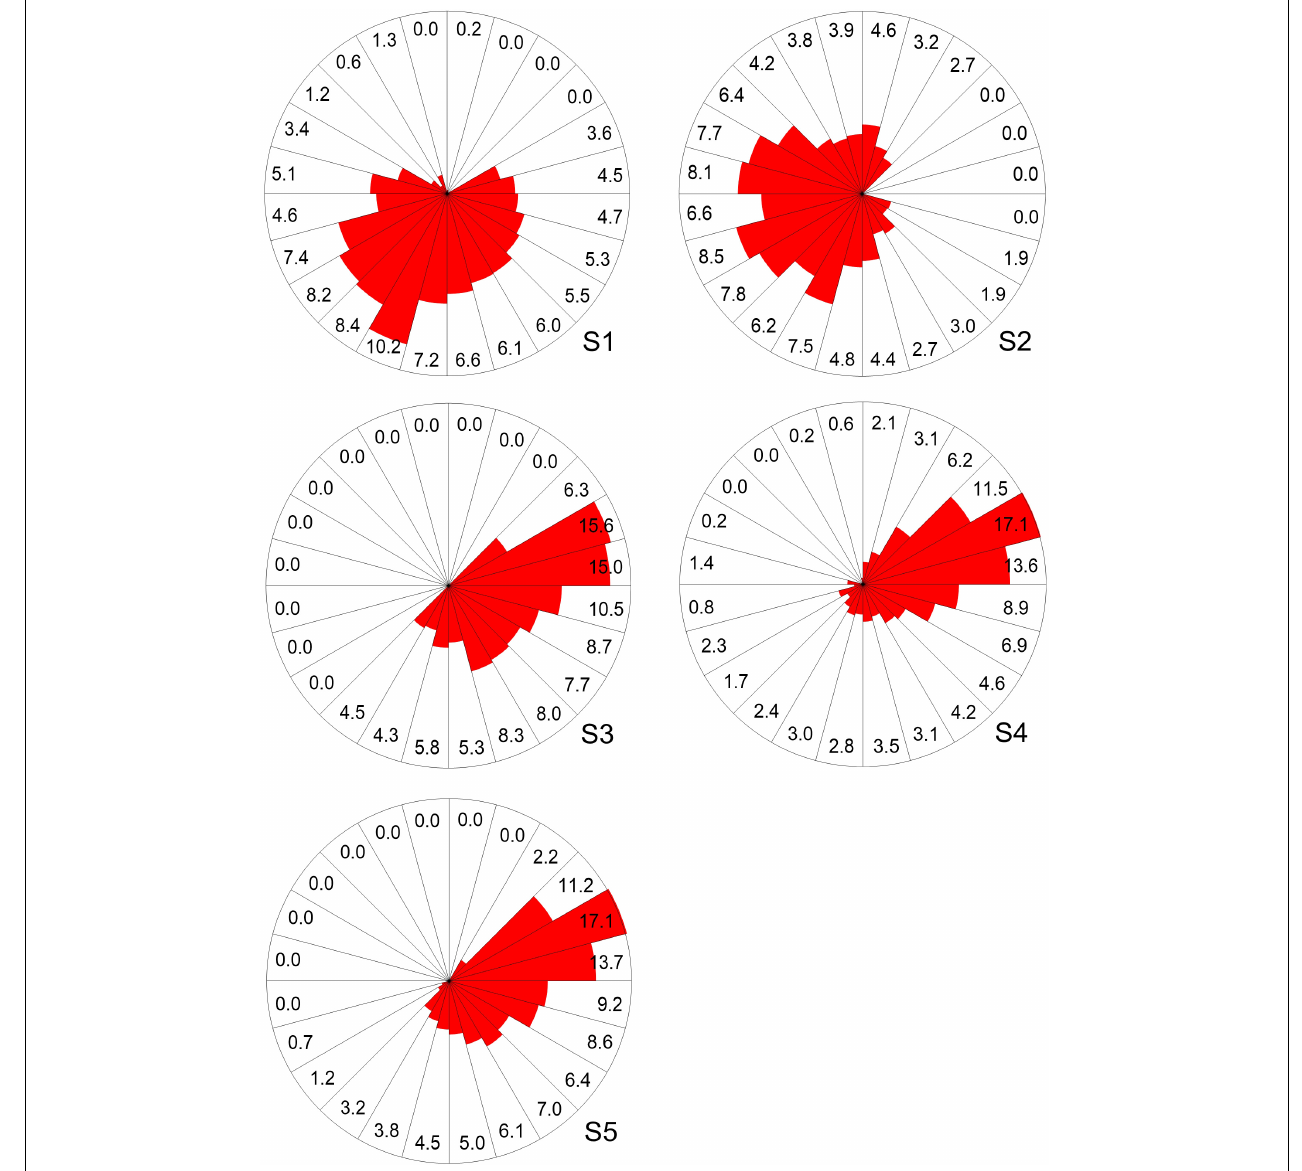
FIGURE 7 | Percentage of the positive cumulative saltwater transport through cross-sections S1–S5 for a 10-year period of 2010–2019 depending on the wind velocity vector